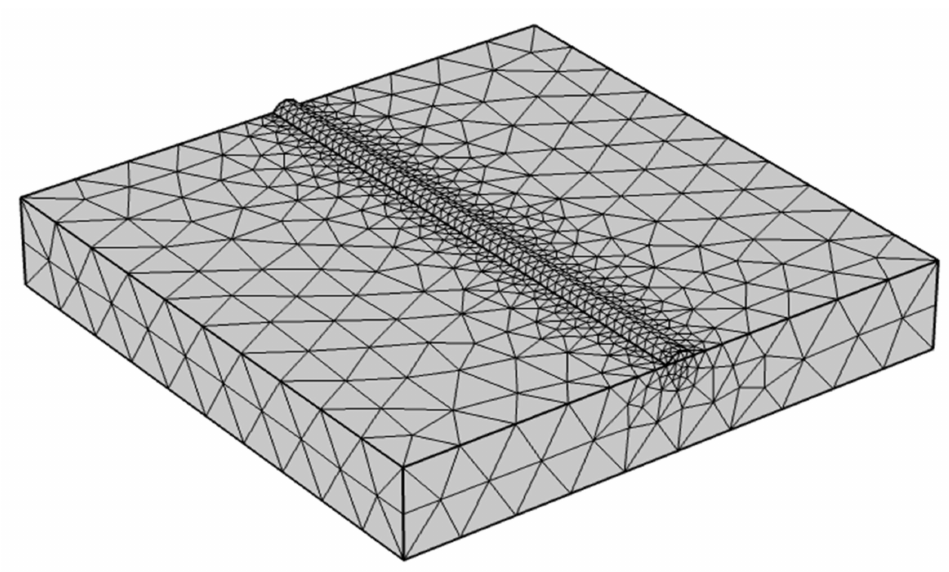
Figure 1. Mesh division of finite element